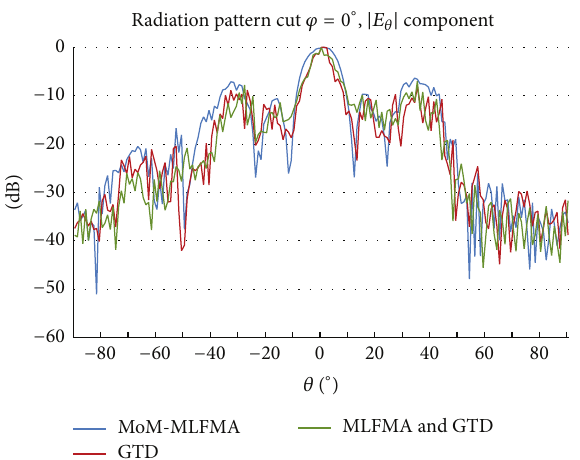
Figure 4: Radiation pattern of the Hispasat at 10.0 GHz, cut 𝜑 = 0 ∘ .